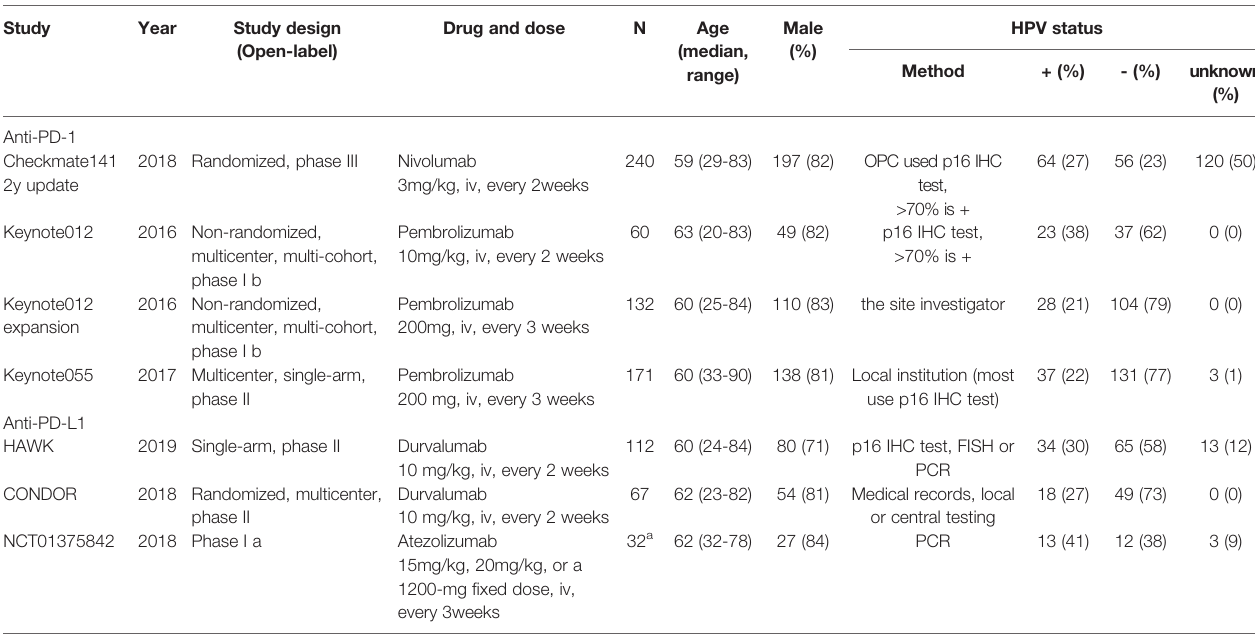
TABLE 1 | The characteristics of the included